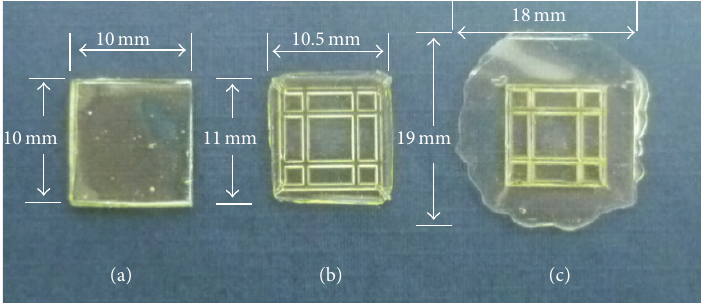
Figure 17: Comparison of the overflow areas. (a) Semifinished PLGA sheet; (b) nonisothermal hot embossed microstructure; (c) isothermal hot embossed